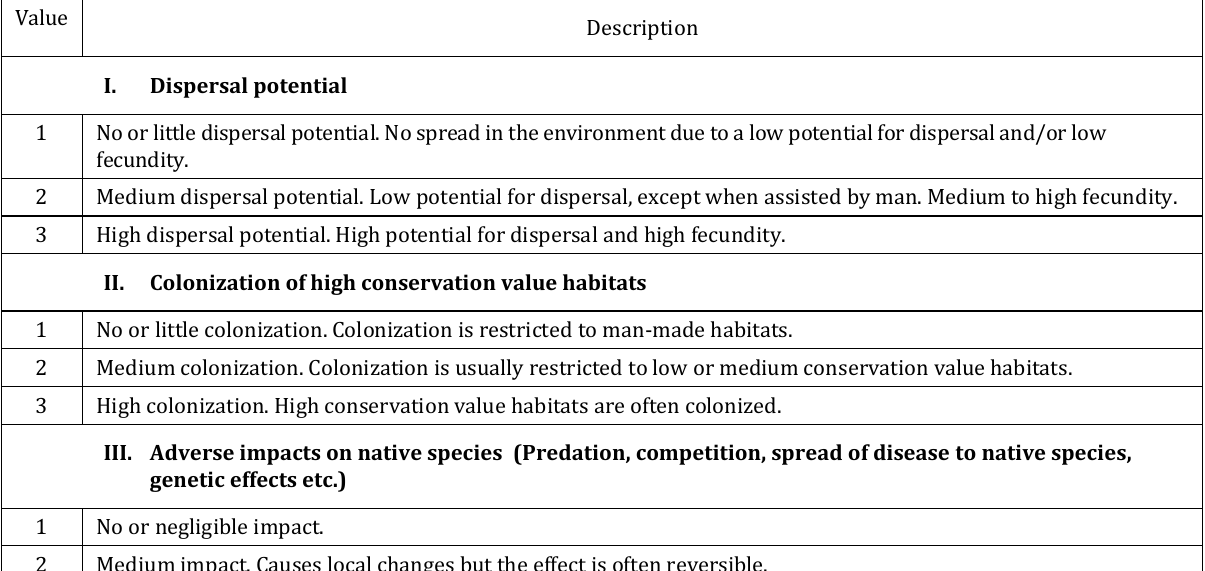
Table 1. Criteria used to assign values for categories of environmental hazards according to HARMONIA system (I-IV)